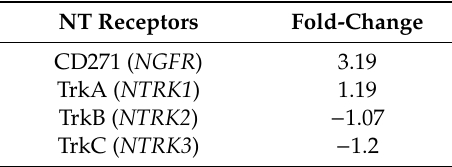
Table 1. Neurotrophin (NT) receptors mRNA fold-change (microarray) in DLX3 overexpressing keratinocytes versus control cells reported by Palazzo et al. (2016) [7].